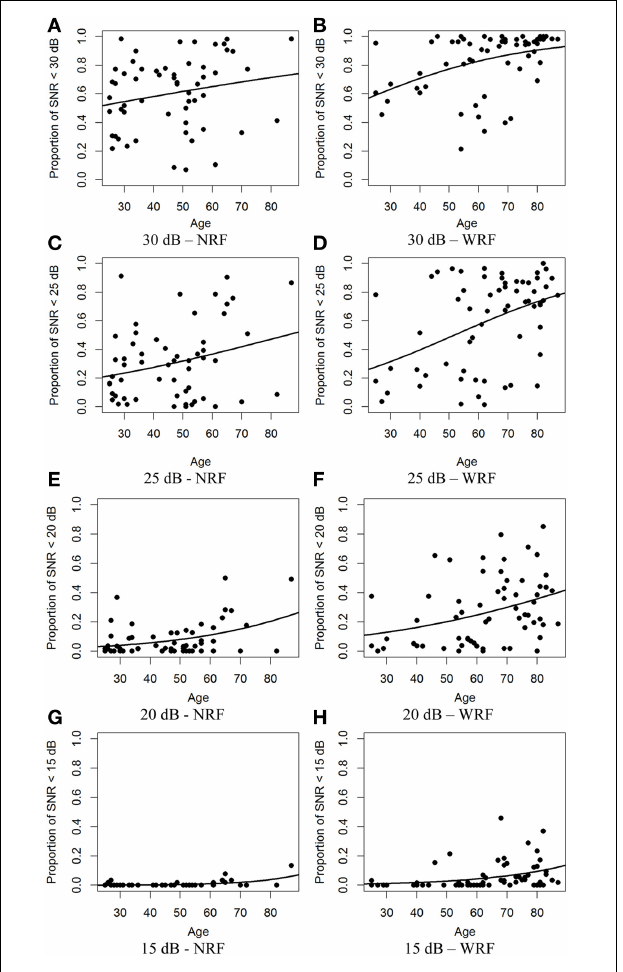
FIGURE 5 | Scatter plots of the proportion of rejected movements when considering the rejection criterion SNR < λ , for different values of λ (in dB). A logistic regression curves has been added to the plots to show the average tendency. The plots ( A , C , E , G ) refer to the population with No Risk Factor (NRF) having a SNR < 30,25, 20 and 15dB, respectively. The plots ( B , D , F , H ) refer to the population With Risk Factor (WRF) under the same SNR